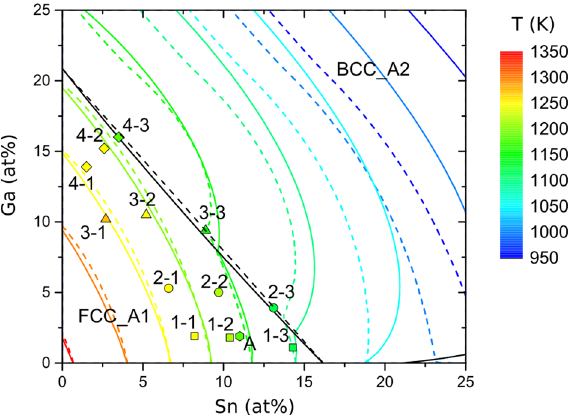
Figure 5. Liquidus projection and compositions of three samples cut from each of the sample rods for DSC measurements (1–1 to 4–3) and a bulk Cu 87 Ga 2 Sn 11 sample (A) with the color filling showing the measured liquidus temperature; the dashed liquidus lines were obtained using polynomial extrapolation from the binary systems, the solid lines were calculated with FactSage; black lines separate regions where the liquid is in equilibrium with different phases (FCC_A1 and BCC_A2, respectively), i.e. they represent univariant equilibria; the solid black line was calculated with FactSage, the dashed line is an approximation by connecting the peritectic concentrations of the liquids in the binary systems.